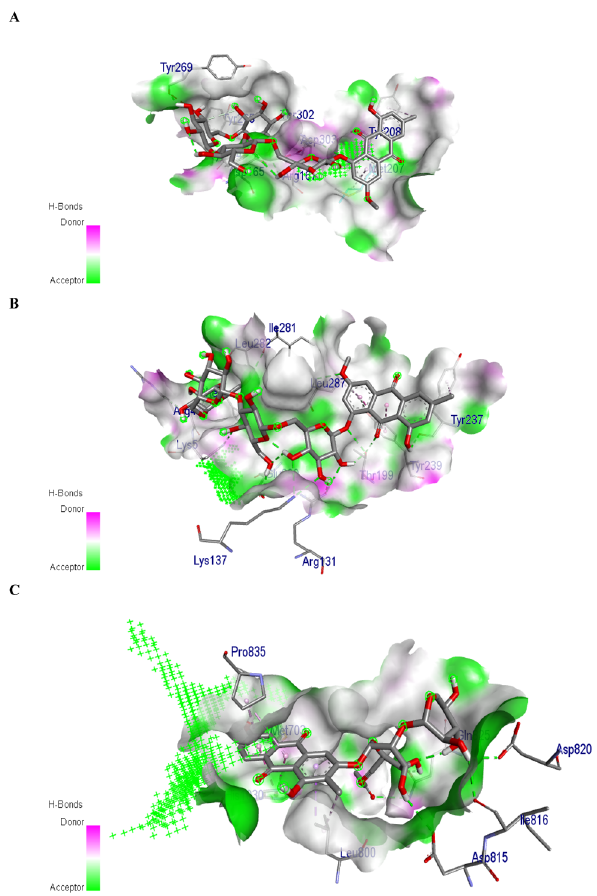
Fig. 4 Interaction of torososide B with ( a ) Papain-like protease and ( b ) coronavirus main proteinase and 1,3,6-trihydroxy-2-methyl-9,10- anthraquinone-3- O -(6 ′ - O -acetyl)- β - d -xylopyranosyl-(1 → 2)- β - d - glucopyranoside ( c ) with spike